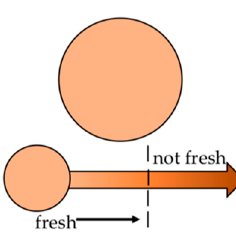
Figure 7. Principle of SensorQ™, Smart Sensor Label by FQSI, adapted from [31]. Gas Indicators